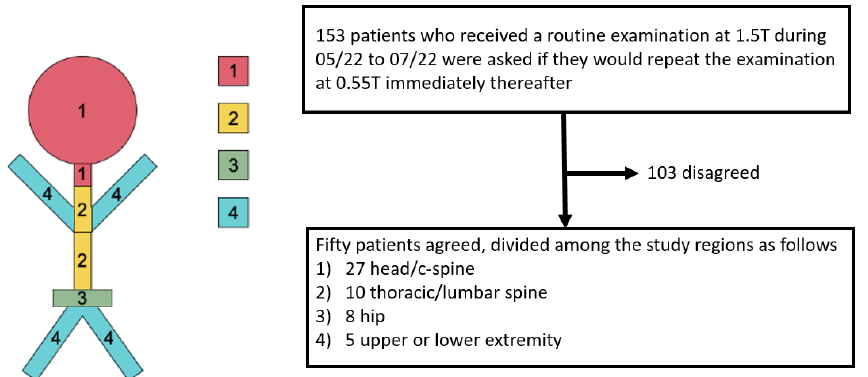
Figure 1. Overview of the patients included and their distribution among the study regions.